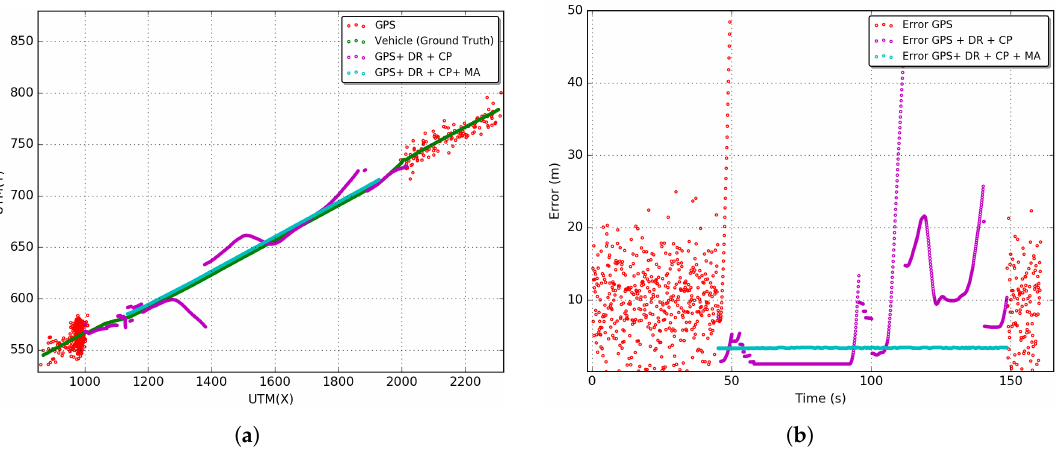
Figure 11. Estimated vehicle positioning and error over time: Robert C. Levy Tunnel (RCLT). ( a ) Estimated vehicle position; ( b ) positioning error over